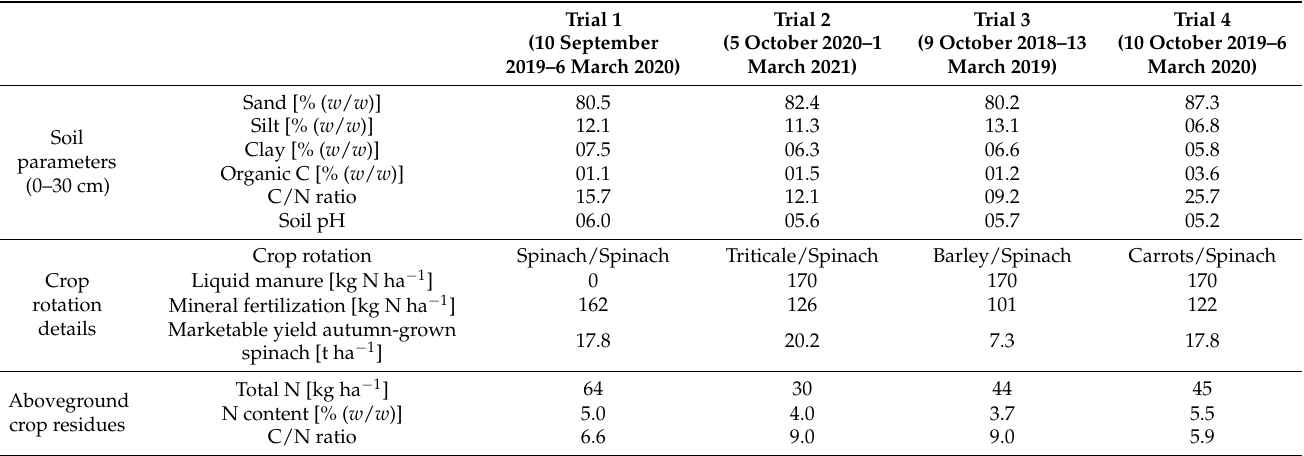
Table 1. Trial periods and soil parameters of the experimental sites as well as details on crop rotations and chemical characteristics of the spinach crop